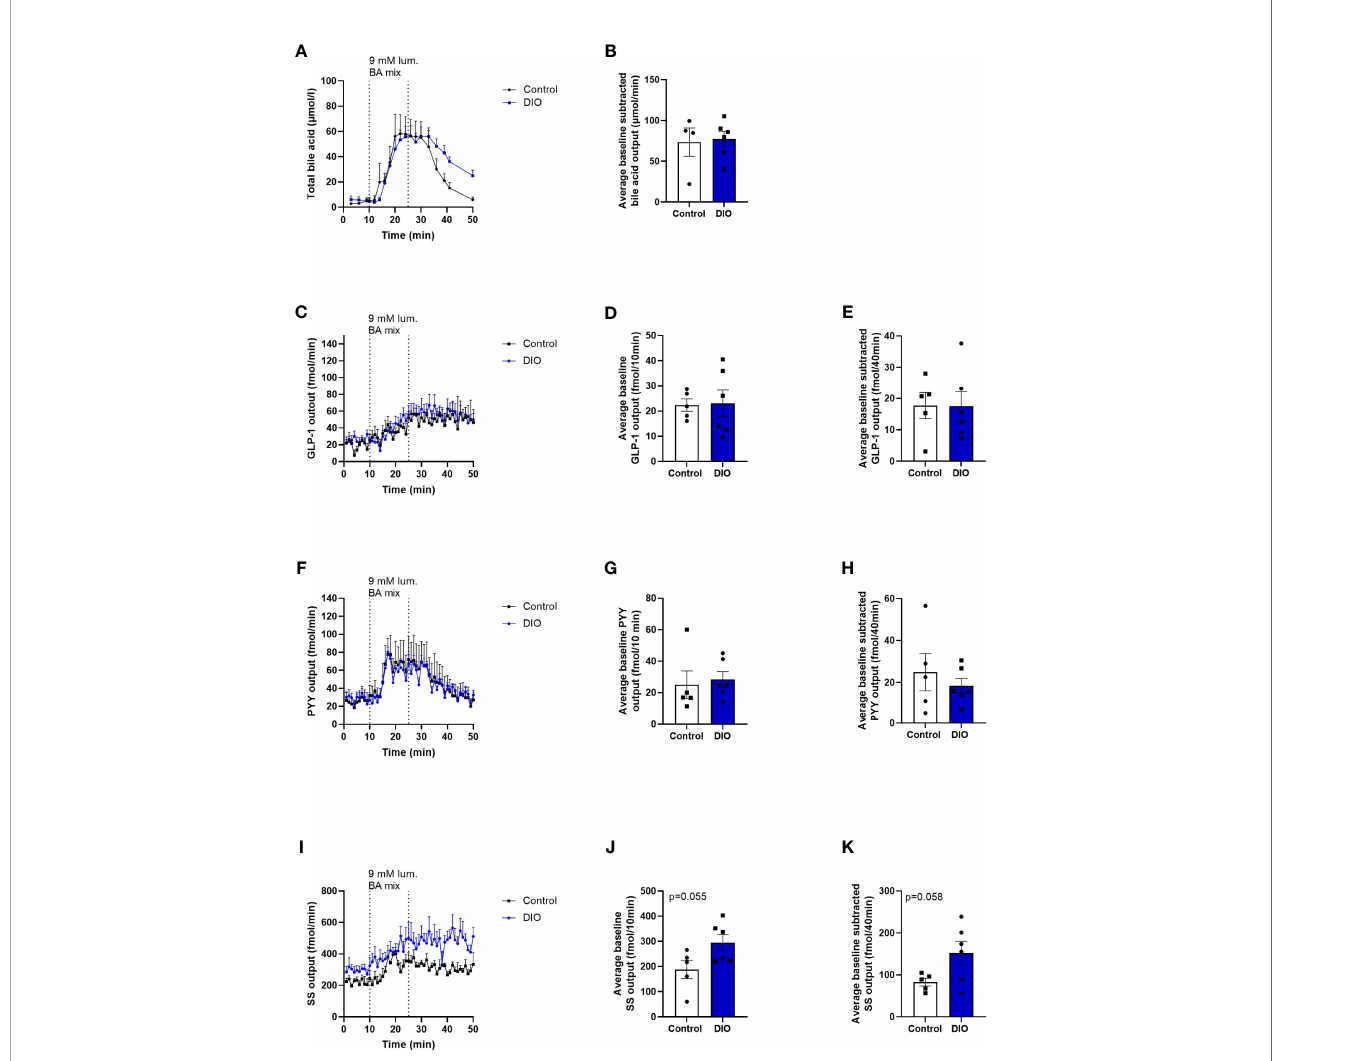
FIGURE 4 | Absorption of BA and the secretion of GLP-1 and PYY are similar, but SS secretion tends to be higher in DIO mice in isolated perfused distal small intestine. (A) BA concentration (mmol/L) measured in the venous ef fl uents from control mice (black line, n = 4) or DIO mice (blue line, n = 6). (B) Average baseline- subtracted BA concentration (absorption) in the venous ef fl uent from 11 to 50 min in control mice (white box) and DIO mice (blue box). (C, F, I) GLP-1, PYY, and SS output in the venous ef fl uent in control mice (black line, n = 5) and DIO mice (blue line, n = 6) in response to luminal BA mix infusion. (D, G, J) Average baseline GLP- 1, PYY, and SS output from 1 to 10 min in control mice (white box) and DIO mice (blue box). (E, H, K) Average baseline-subtracted GLP-1, PYY, and SS output during luminal BA infusion from 11 to 50 min in control mice (white box) and DIO mice (blue box). Each dot represents outputs from each experiment. Data are presented as mean ± SEM, and statistical signi fi cance was evaluated by a two-sided, unpaired Student ’ s